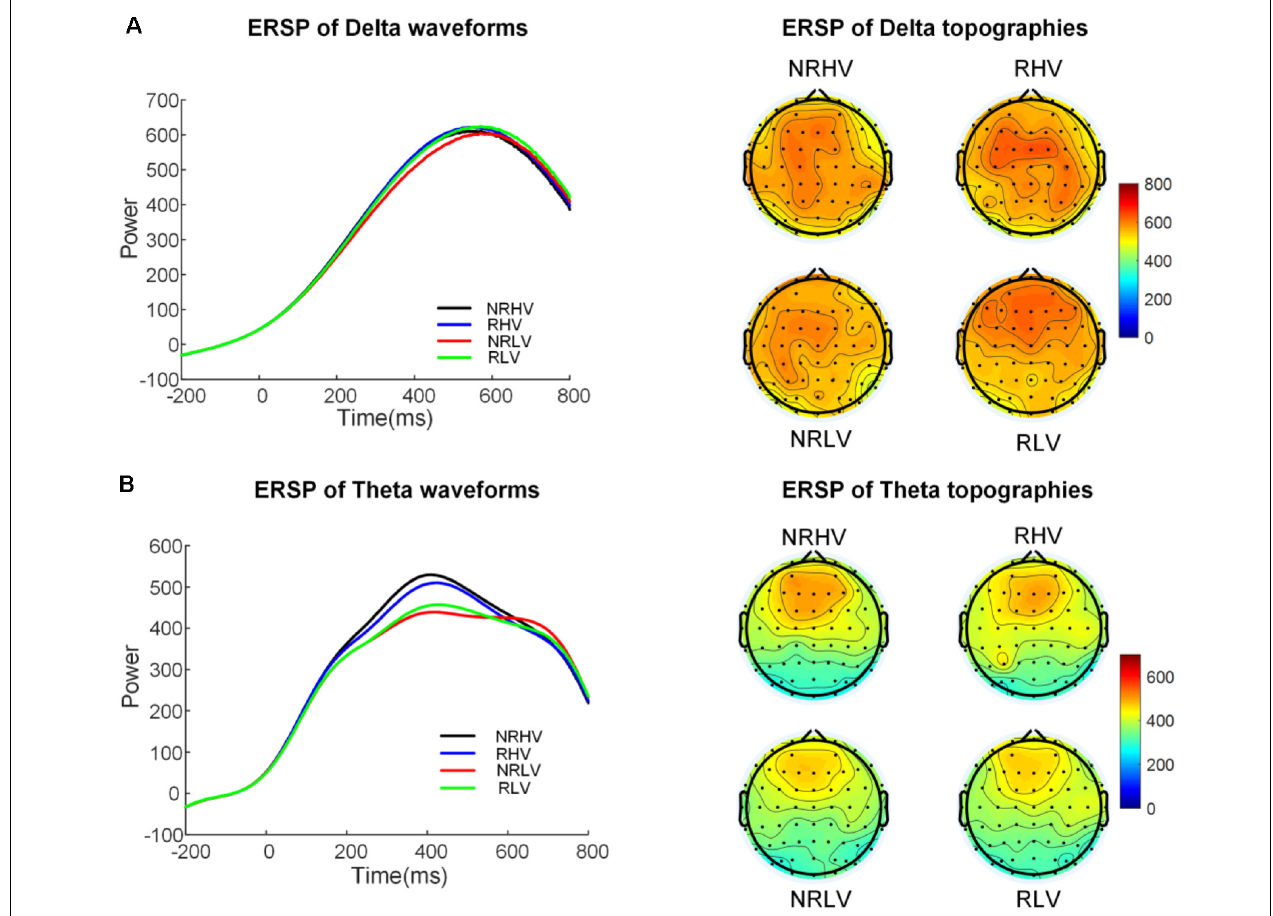
FIGURE 6 | The temporal waveforms of power modulation and topographies of the delta (A) and the theta band (B) in the four experimental